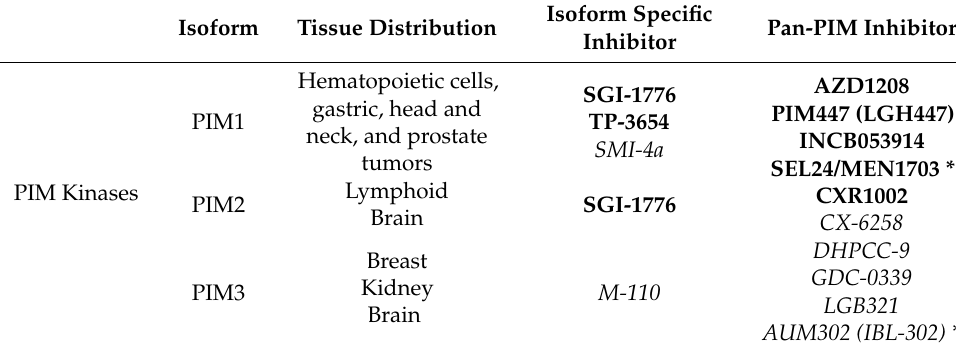
Table 1. PIM kinase inhibitors tested clinically and experimentally. PIM Kinases